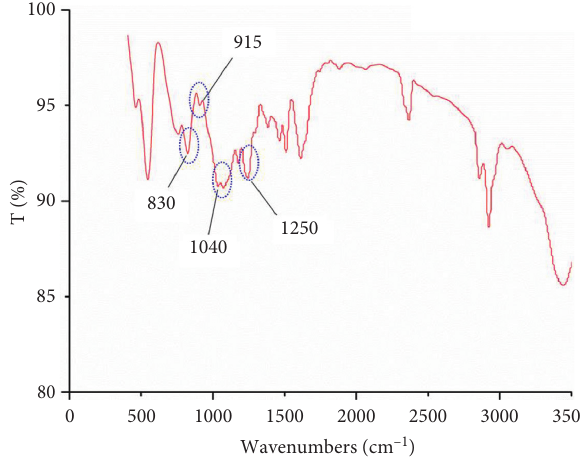
Figure 11: The FTIR spectrum of the microbial